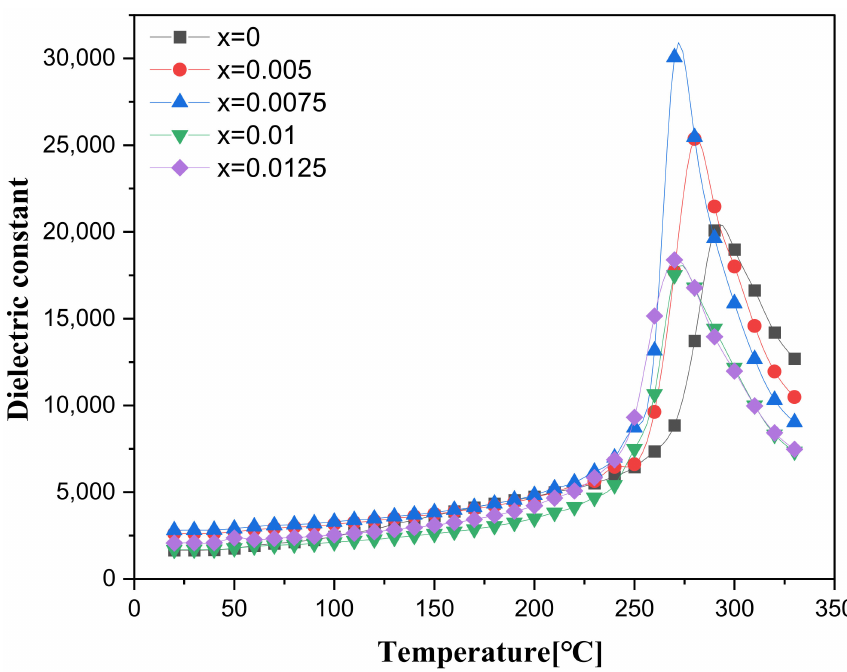
Figure 9. Temperature dependence of dielectric constant ( ε r ) with Sm